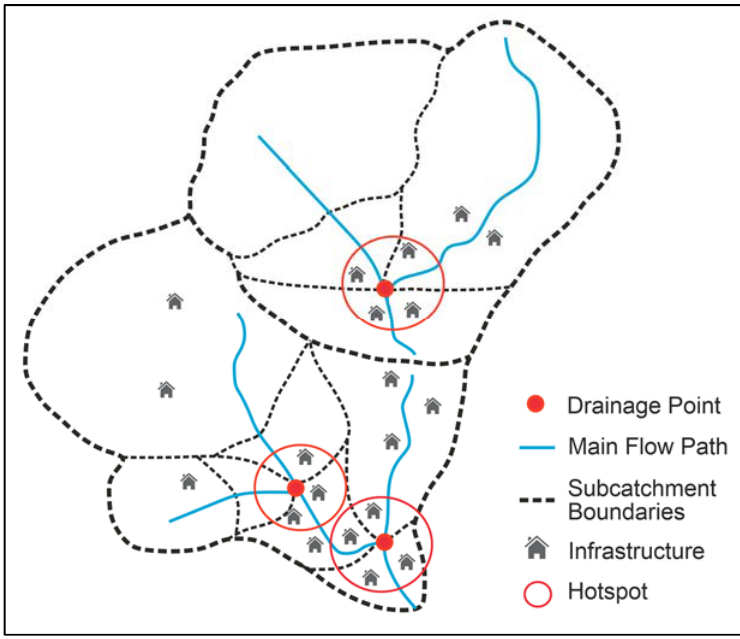
Figure 2. Localization of hotspots and urban subcatchments (USC).